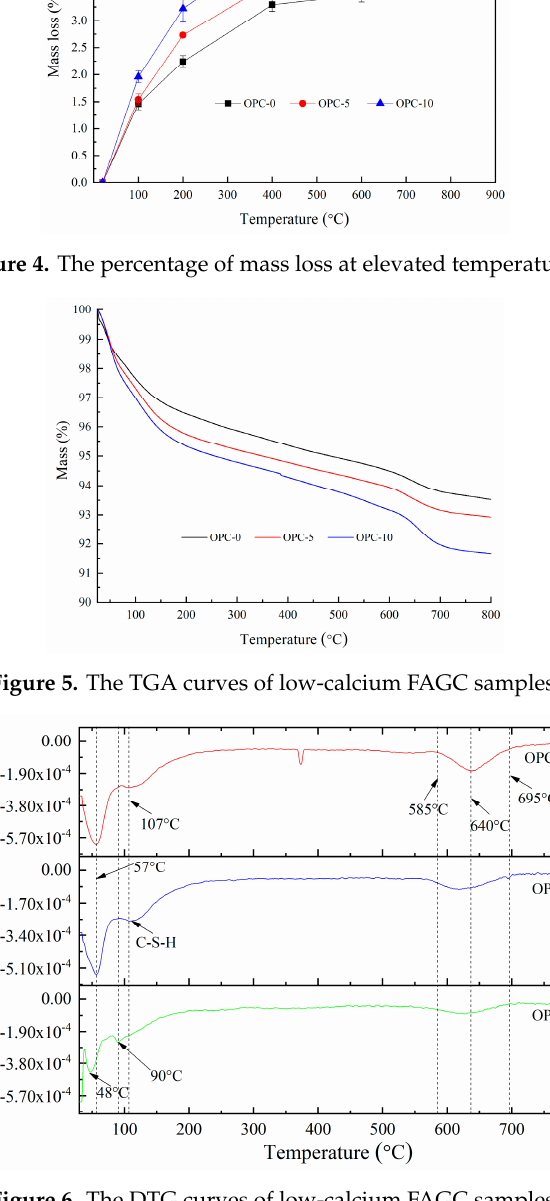
Figure 6. The DTG curves of low-calcium FAGC samples.